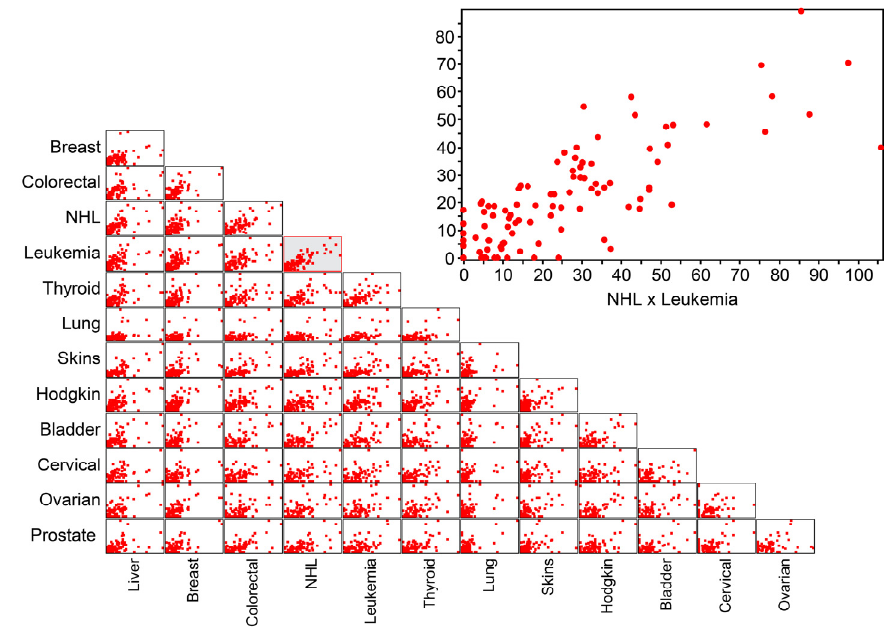
Figure 6. Scatterplot matrix of the incidence rates of the most common cancers, highlighting NHL and leukemia